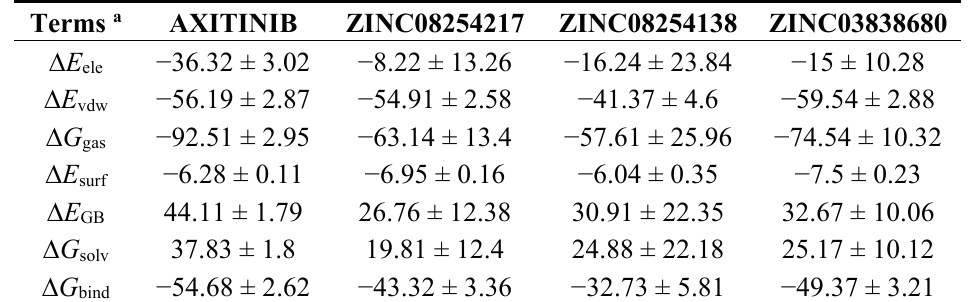
Table 2. The predicted binding free energy (kcal/mol) for each VEGFR-2 inhibitor via MM/GBSA